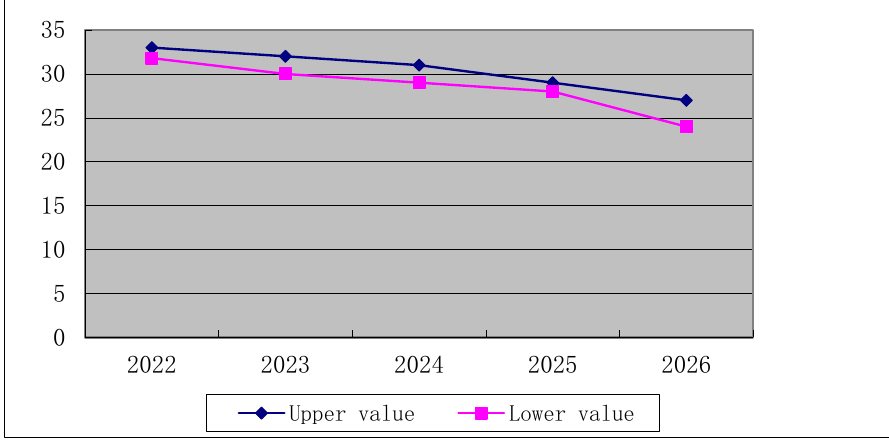
Figure 9. The variation interval of water requirement with the influence of the population in Tian- jin.